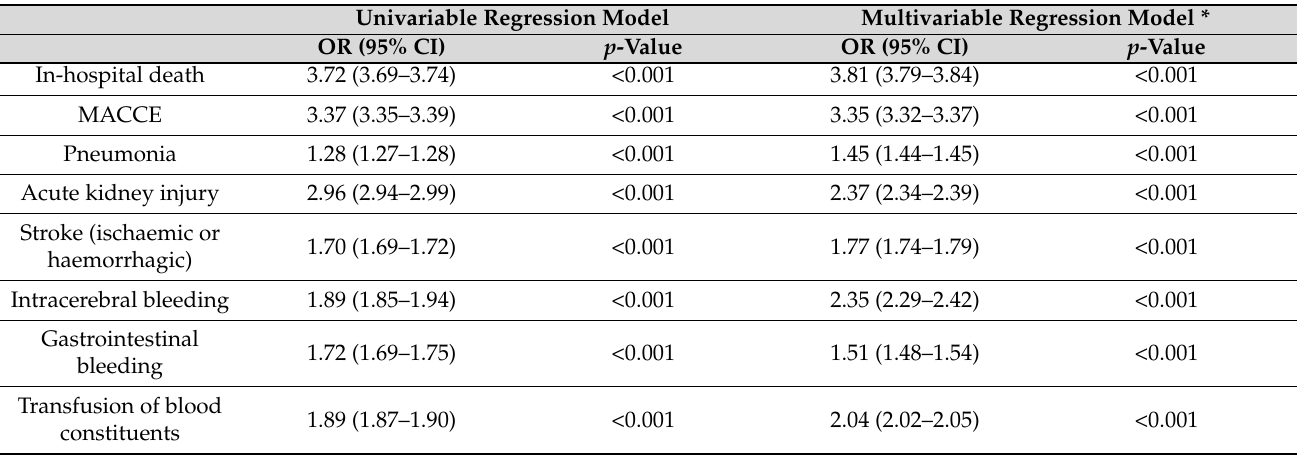
Table 3. Prognostic value of the CRB-65 score for prediction of adverse in-hospital events. Association of an increase in CRB-65 score by 1 with the adverse in-hospital events (univariable and multivariable logistic regression